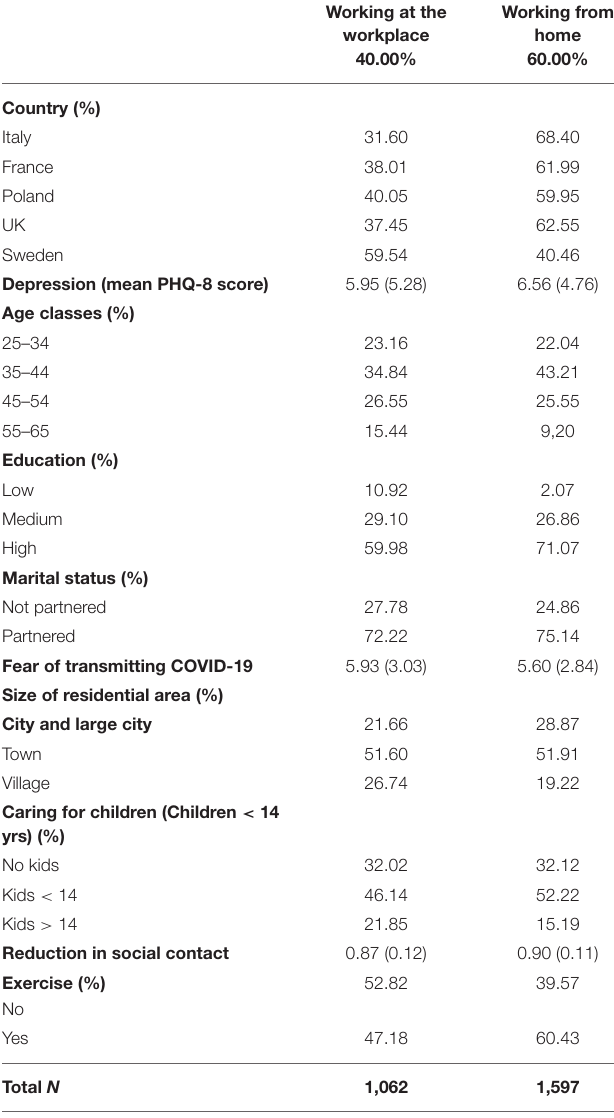
TABLE 2 | Description of the sample and distributions.